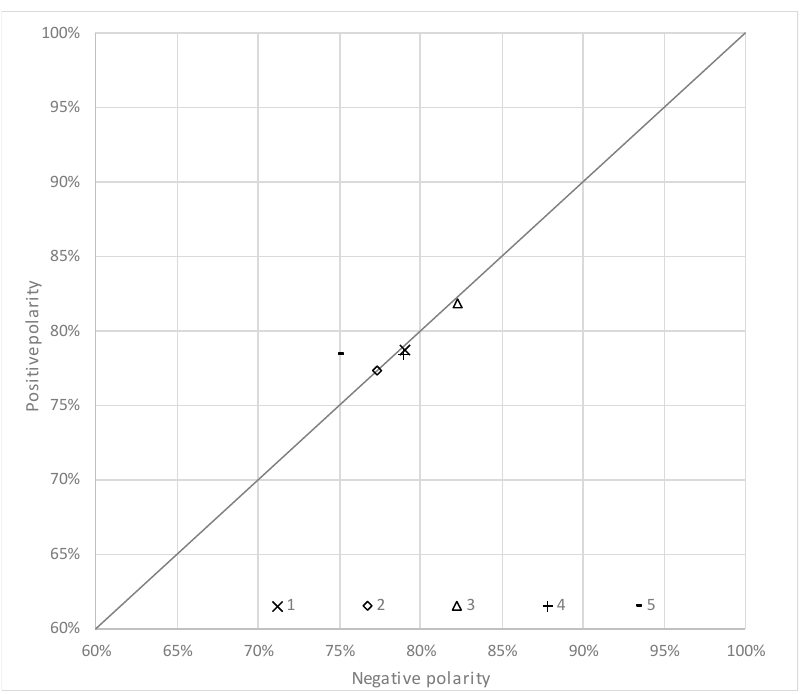
Figure 14. Product PSD after a different number of pulses (feed monosize 500/125 µm) and differ- Figure 14. ProductPSDafteradifferentnumberofpulses(feedmonosize500/125 µ ent polarity.